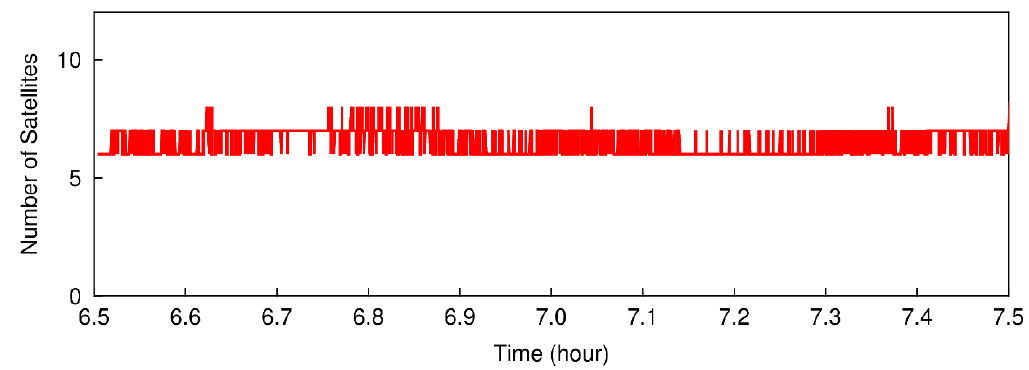
Figure 2. The number of visible GPS and Galileo satellites with dual-frequency observations.